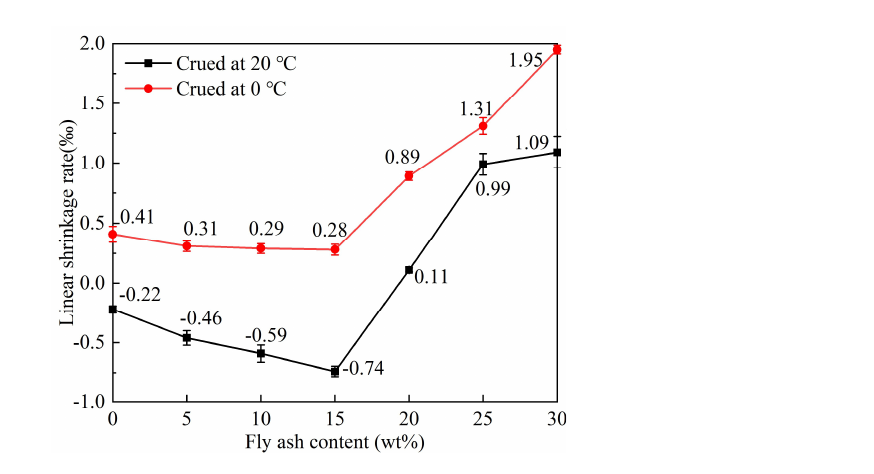
Figure 8. The variation of linear shrinkage rate with mixing temperature and fly ash content.